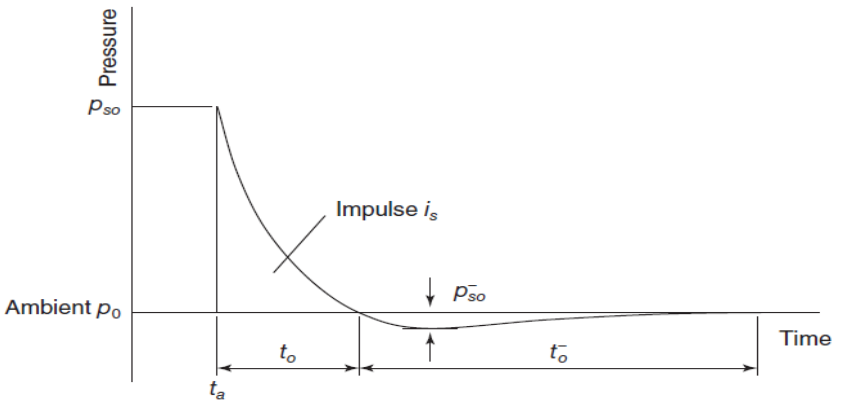
Figure 3. Typical blast pressure–time profile.